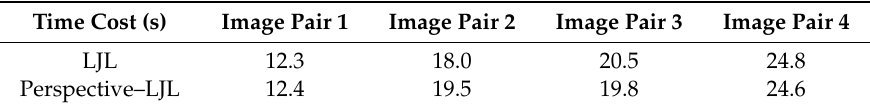
Table 4. Comparison of processing time consumption of the two